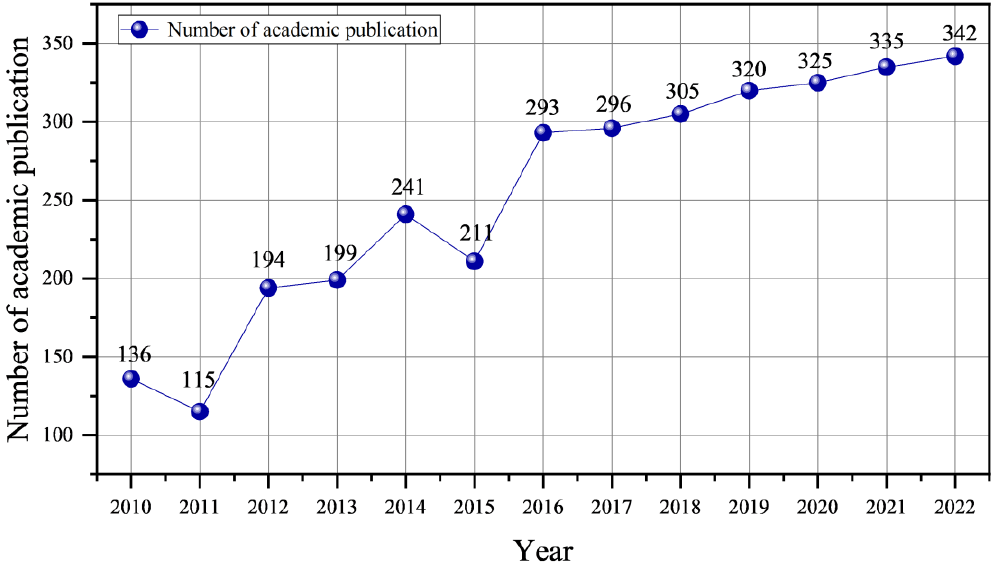
Figure 2. Number of academic publications in fire safety evacuation from 2010 to 2022. Two main bursts of academic publications are shown in 2012 and 2016, with an in- crease of 68.7% and 38.9%, respectively. The number of academic publications goes through a steady development stage after each growth. Publications in fire safety evacu- ation show an overall growth from 2015 to 2022, and the longest period of steady devel- opment exists from 2016 to 2022, which shows that the research in this field is developing smoothly and sustainably.